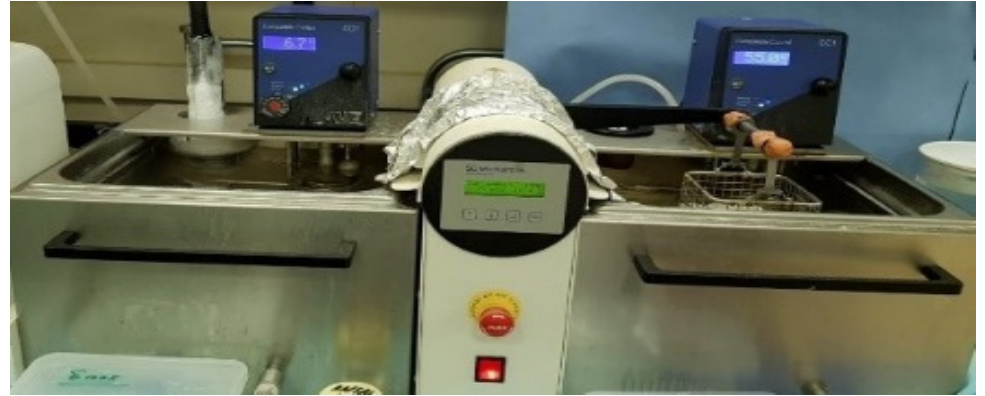
Figure 2. Thermocycling from 5 °C to 55 °C for 3000 cycles using a dwell time of 30 s.